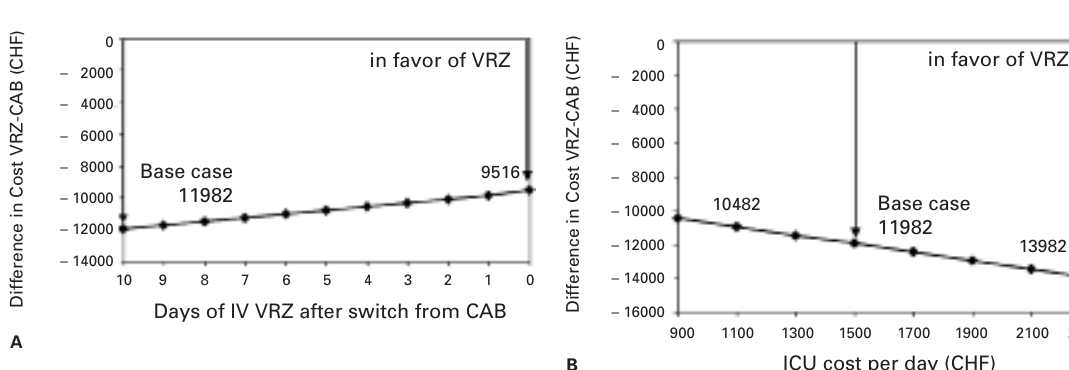
Average total cost estimates for conventional amphotericin B or voriconazole as initial treatment for invasive asper- gillosis: Total treatment costs of CHF 37878/patient and CHF 49861/patient resulted for voriconazole and conventio- nal amphotericin B, respectively. Despite a small gain in ab- solute drug costs if conventional amphotericin B was used as first line treatment and only changed to voriconazole in case of renal failure or non-response, overall costs including use of hospital resources and additional costs due to renal toxicity resulted in cost savings if treatment of invasive aspergillosis was initiated with voriconazole. ARF = acute renal failure; CHF = Swiss francs